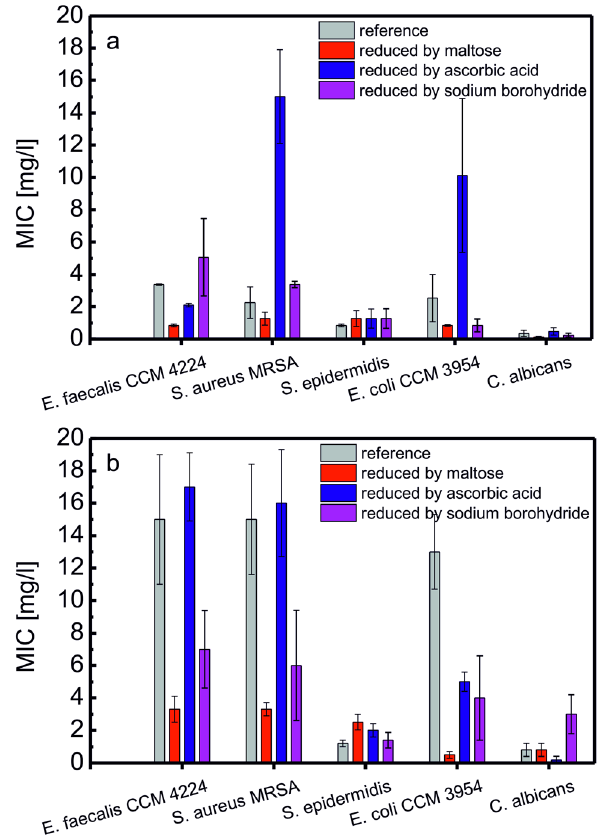
Figure 4. Minimum inhibitory concentrations of the AgNPs reduced by maltose, ascorbic acid, and sodium borohydride in systems influenced by the presence of gelatin at a concentra- tion of 0.05% (w/w). Determined after one week (a) and after three months (b).